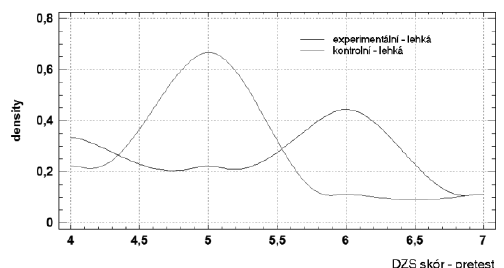
Figure 1. Distribution of difference between input and output testing – “Questionnaire of changed seniors’ abilities” - experimental group - pretest (W = 62,5 P-value = 0,359974), (blue line = experimental group, light type; red line = control group, light